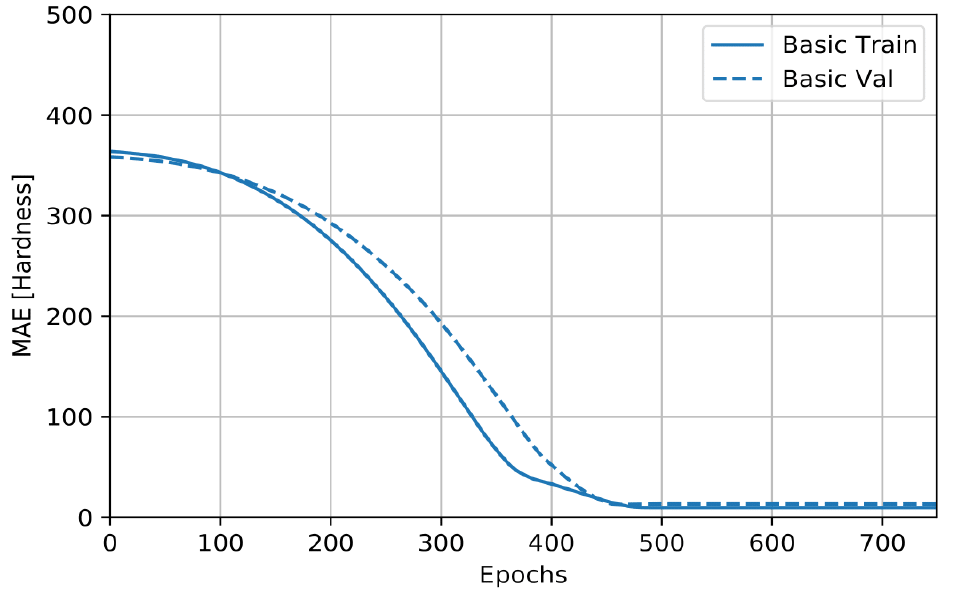
Figure 10. Plots of MAE against number of epochs.